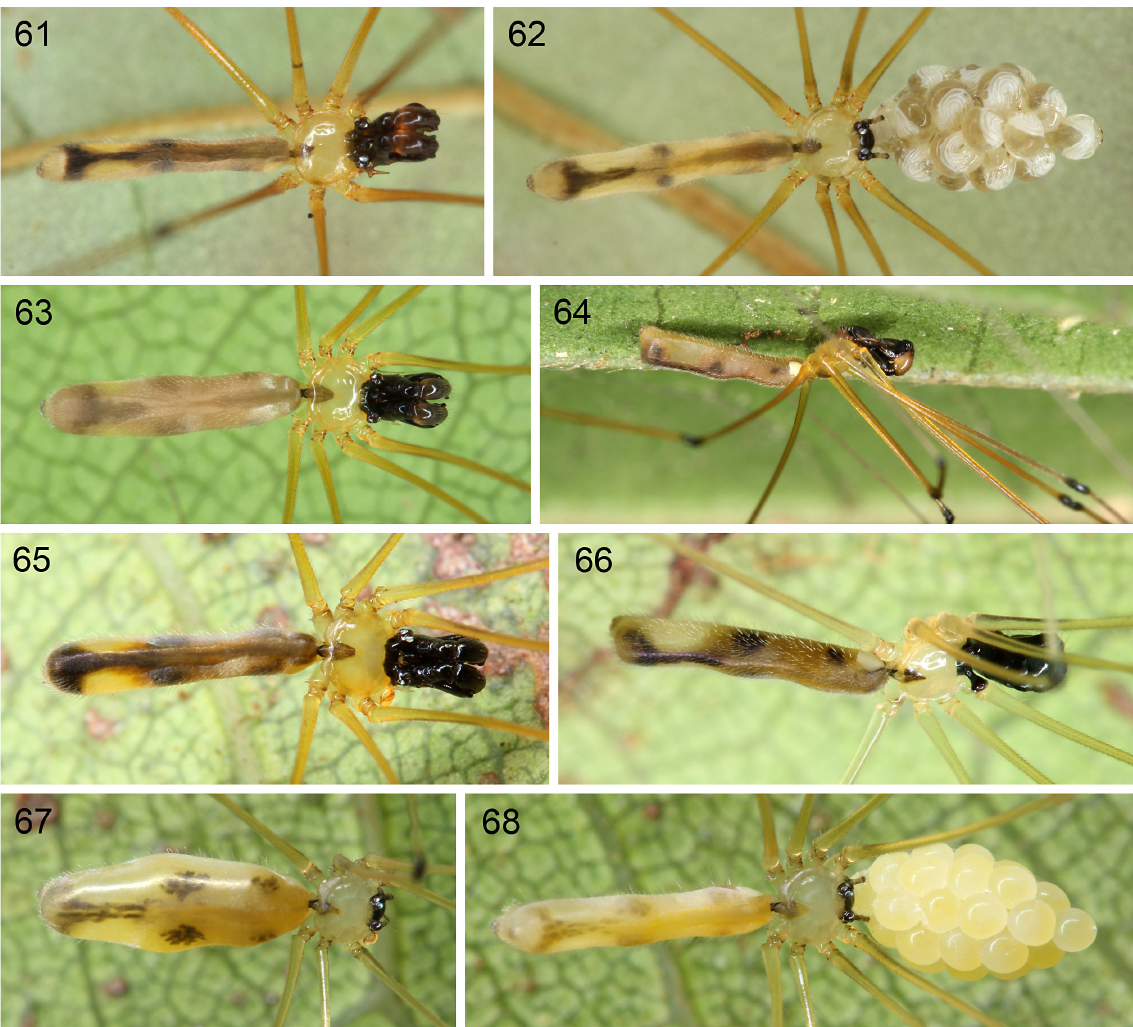
Figs 61–68. Live specimens. 61–62. Pa. iban Huber, 2011, ♂ and ♀ with egg-sac from Semengoh. 63–64 . Pa. kubah Huber, sp. nov., ♂ from Kubah. 65–68 . Pa. seowi Huber, sp. nov., ♂, ♀, and ♀ with egg-sac from